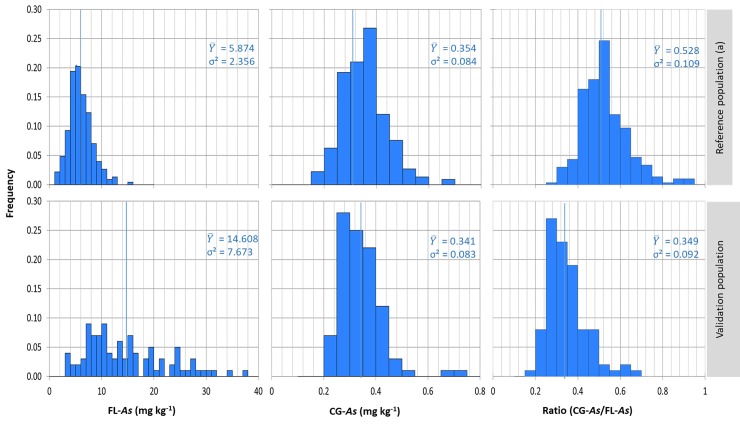
Distribution of adjusted phenotypic values for flag leaf arsenic content (FL-As), Cargo grain arsenic content (CG-As), and the CG-As/FL-As ratio, in the reference (RP) and validation (VP) populations.a: data from 2014 field experiment. The vertical blue line indicates the mean value of arsenic content the in the population.